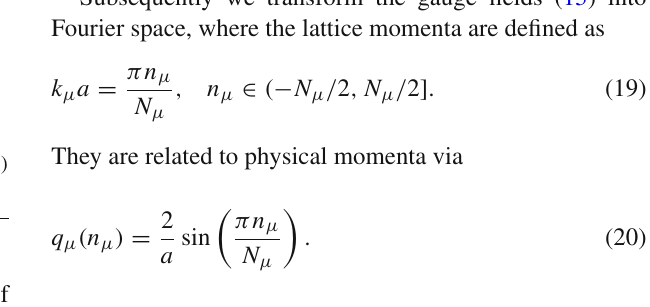
Table 1 Properties of the three sets of finite-temperature ensembles used in our study, among them the deconfinement cross-over tempera- ture T deconf (defined by the Polyakov loop susceptibility) ETMC ens. ( T =